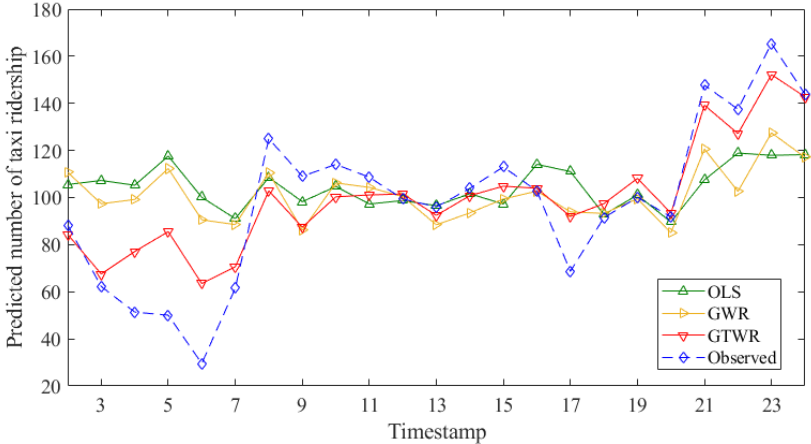
Figure 10. Temporal variations in the predicted and observed values.